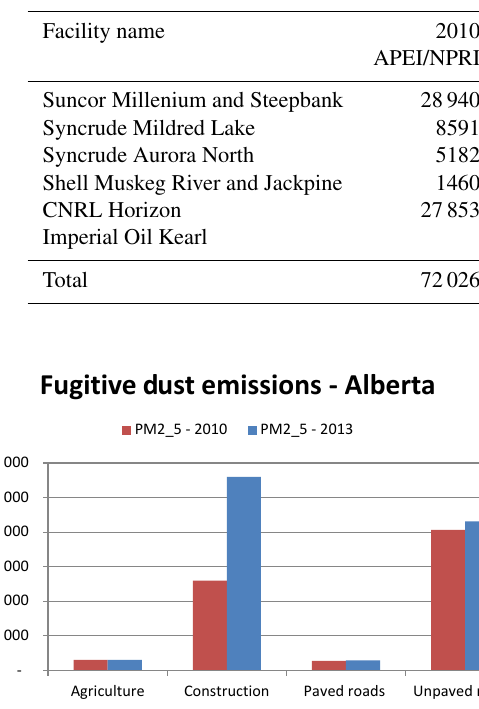
Figure 2. Comparison of fugitive PM 2 . 5 emissions for four sectors between 2010 APEI (used for phase 2) and 2013 APEI (used for phase 3) for the province of